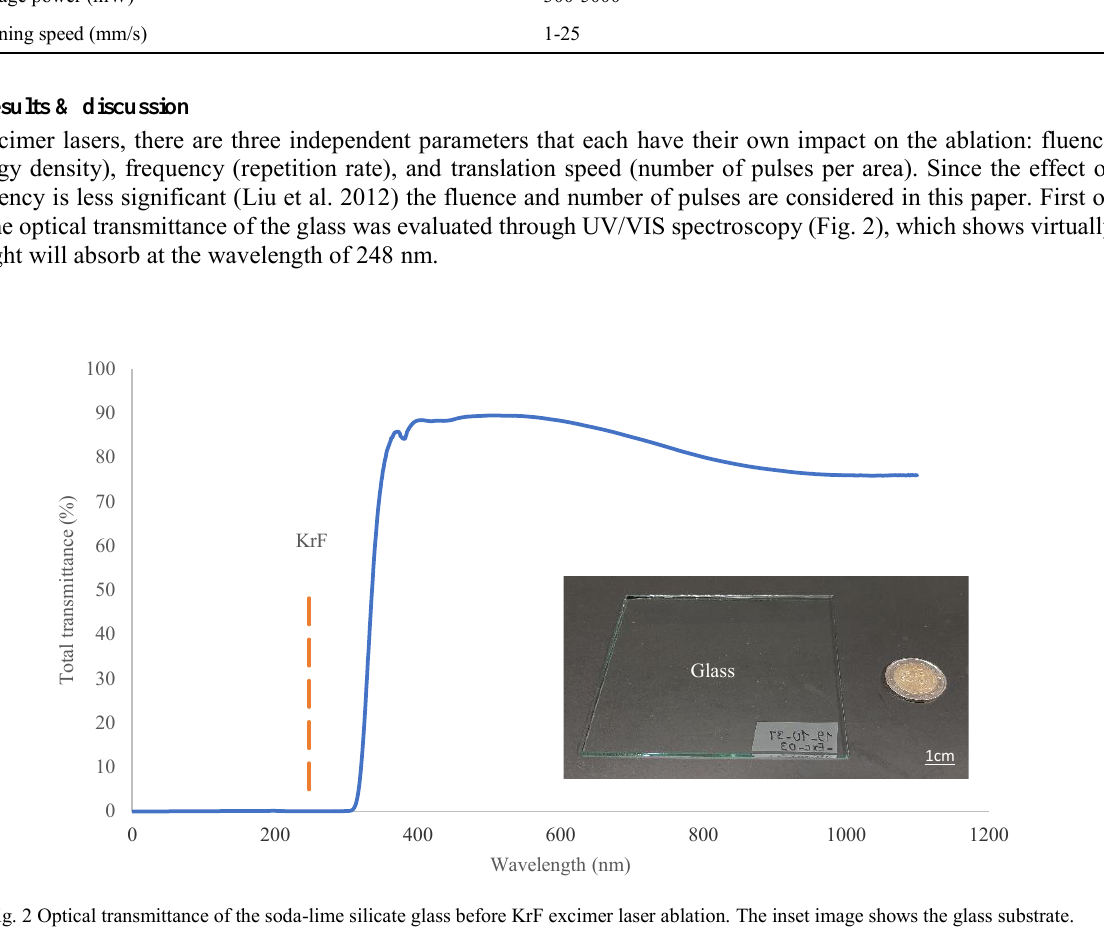
Fig. 2 Optical transmittance of the soda-lime silicate glass before KrF excimer laser ablation. The inset image shows the glass